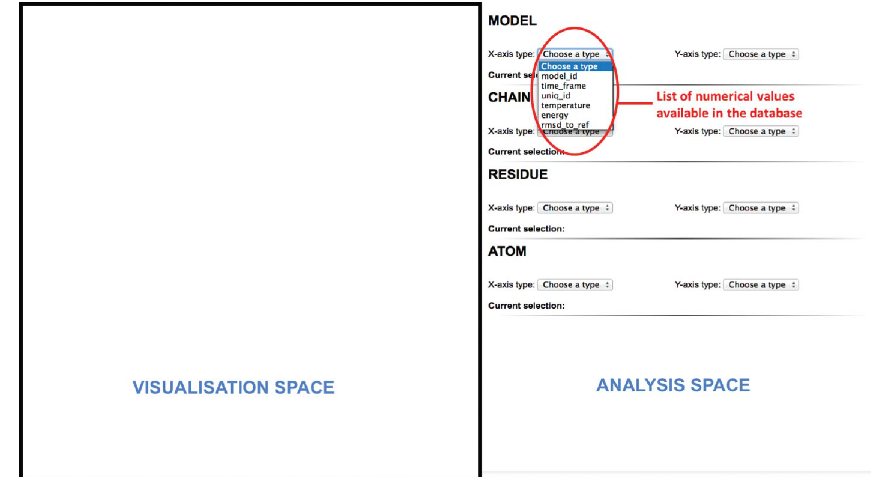
Figure 7: Query results showing all present numerical values from the database for each representation level available